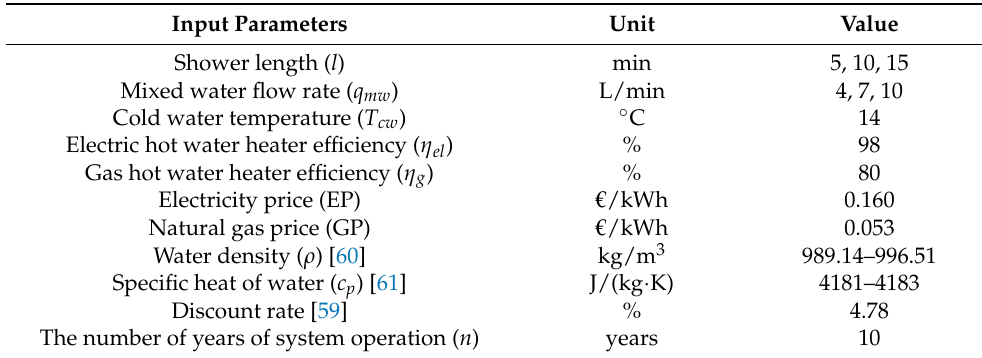
Table 2. Assumed values of the input parameters for the profitability analysis of the compact shower heat exchanger